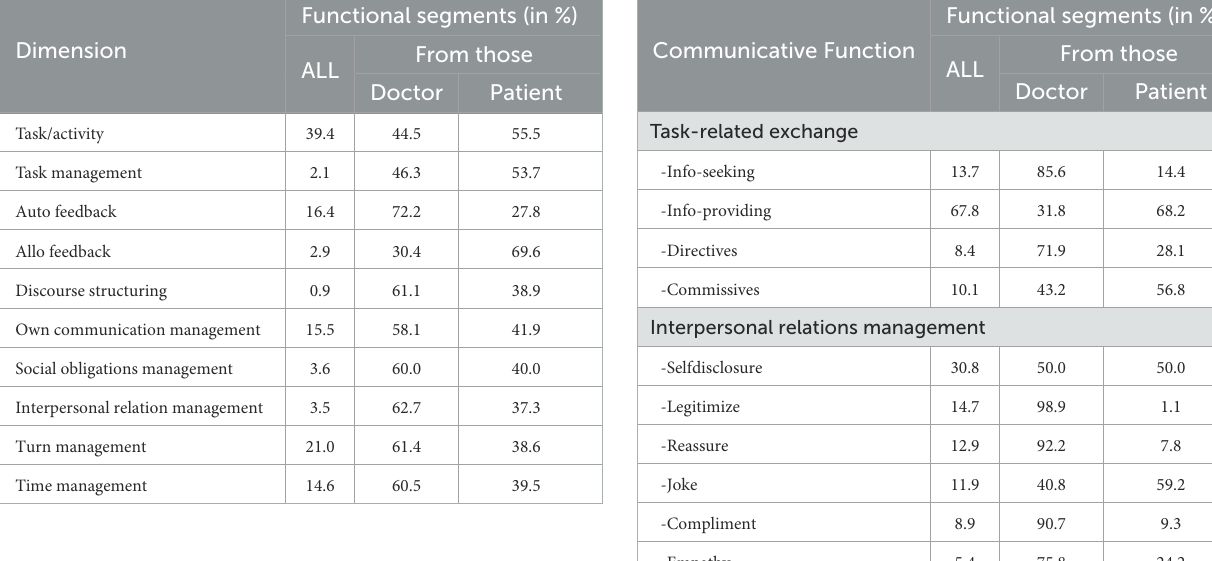
TABLE 3 Distribution of doctor and patient task-related and interpersonal relations management dialog acts, in terms of relative frequency (in